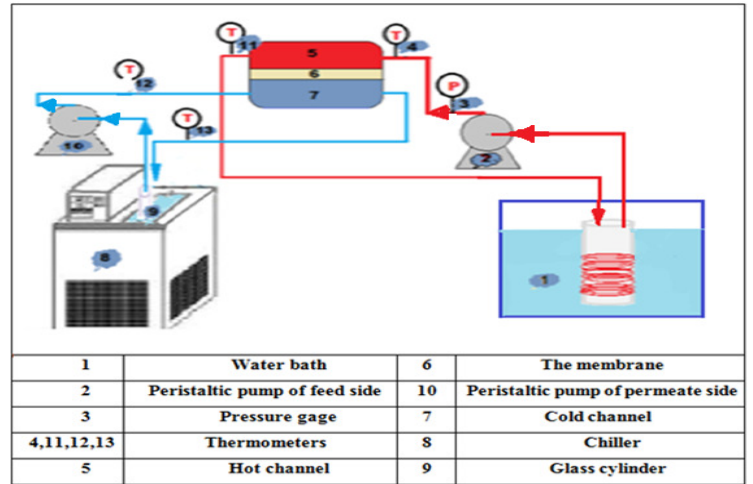
Fig. 3. schematic diagram of the experimental rig of DCMD process.